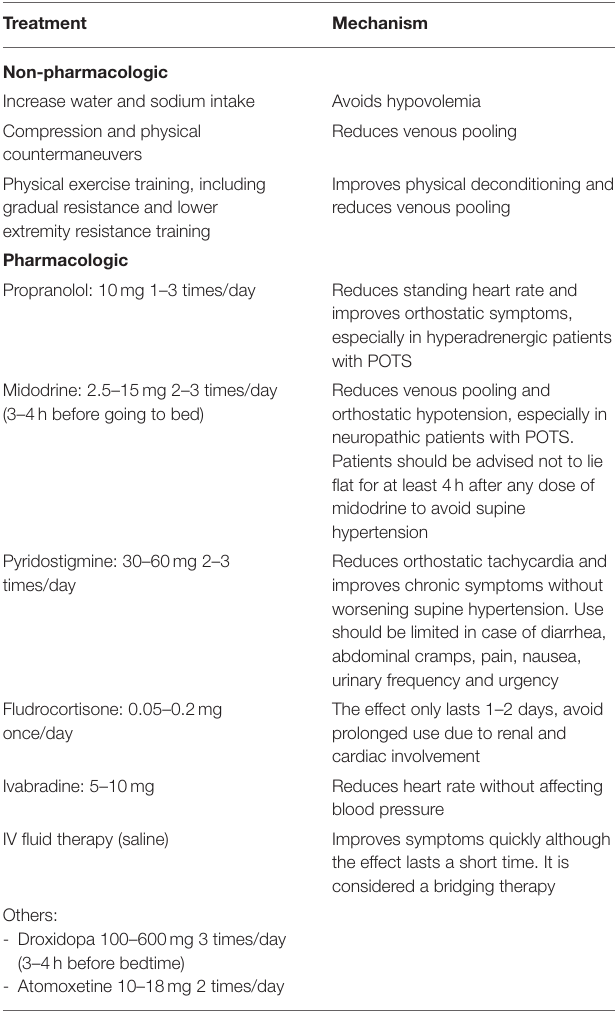
TABLE 3 | Therapeutic proposal for orthostatic intolerance and intended effects (71,